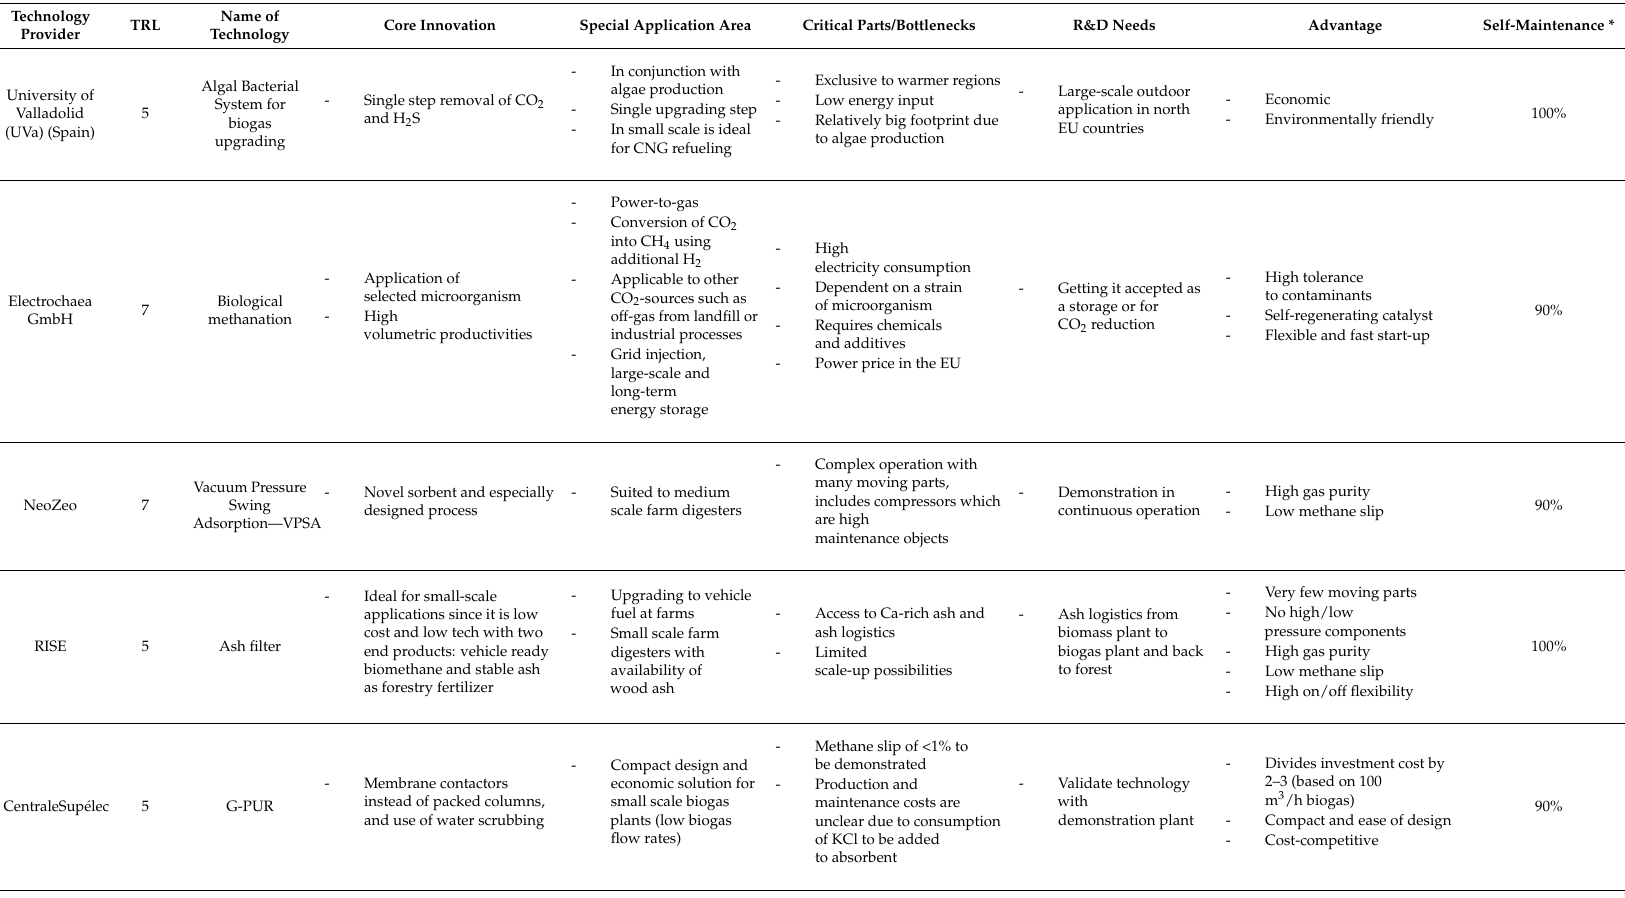
Table A3. Additional information for upgrading